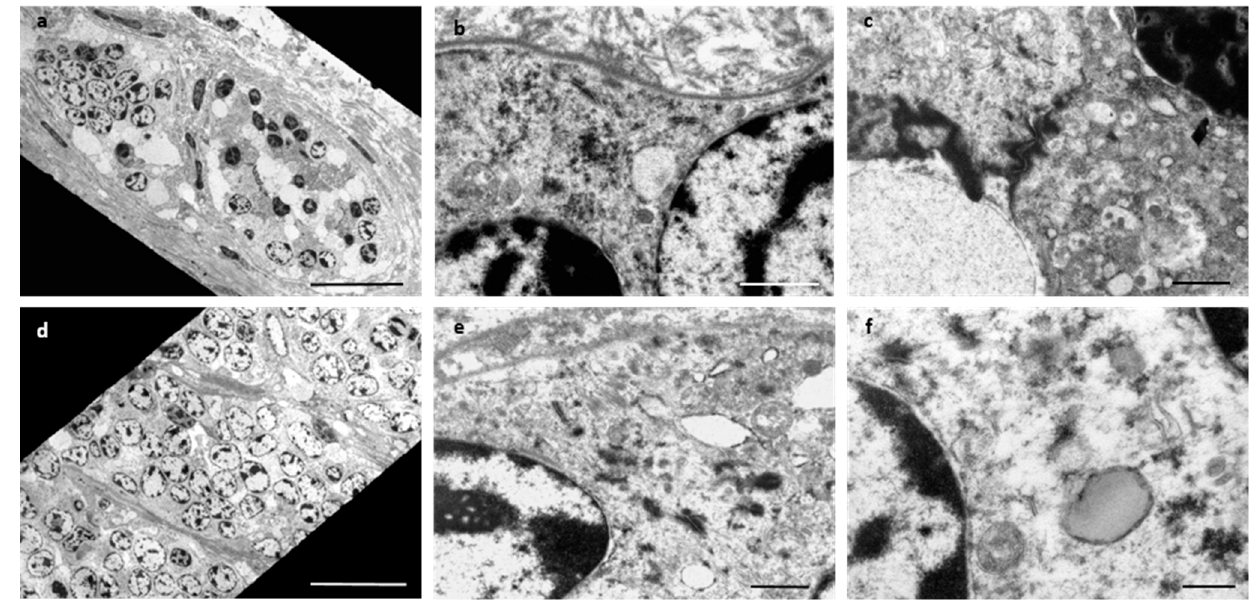
Figure 4. Transmission electron microscopy of the neoplastic cells in the uterus and liver. The neoplastic cells in the uterus ( a – c ) and the liver ( d – f ) were arranged in groups ( a , d ) surrounded by basement membranes and interspersed with collagen fibrils ( b ). Intermediate filaments ( e ) and sparse lipid droplets ( f ) were evident in the cytoplasm. Attachments ( b , e , f ) were present between cells and junctional complexes ( c ) and appeared at some cell surfaces. Bar = 20 μ m ( a , d ); 1 μ m ( b , c , e ); 500 nm ( f ).